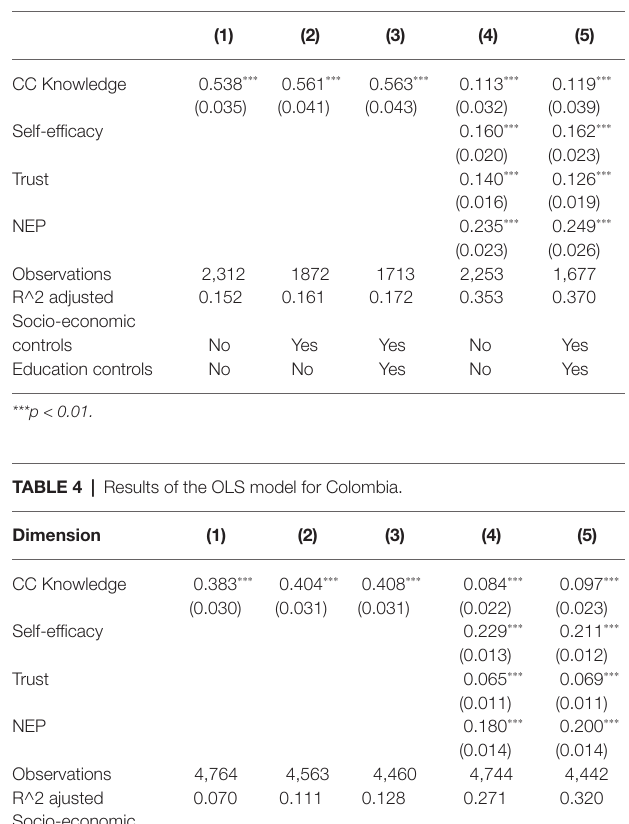
TABLE 3 | Results of the OLS model for Nicaragua.